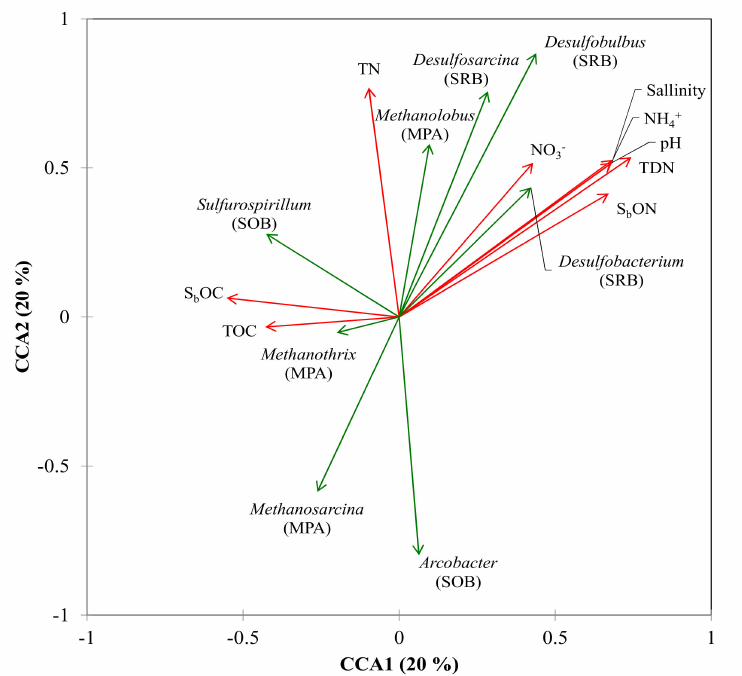
Figure 8. The relationship between diazotrophs and soil physiochemical properties in Guandu and Bali mangrove forests based on Canonical Correlation Analysis (CCA). SRB: sulfate-reducing bacteria; SOB: sulfur-oxidizing bacteria; MPA: methane-producing